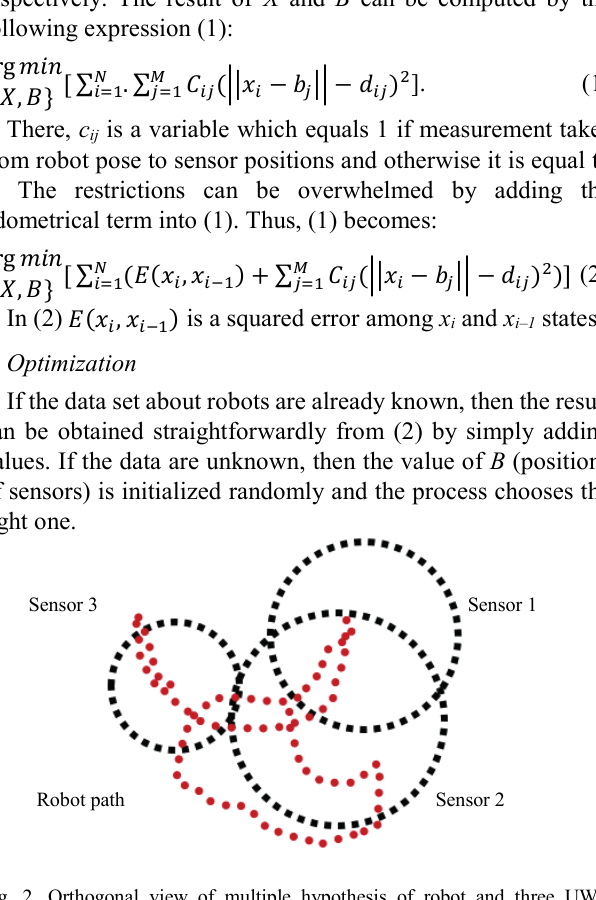
Fig. 2. Orthogonal view of multiple hypothesis of robot and three UWB